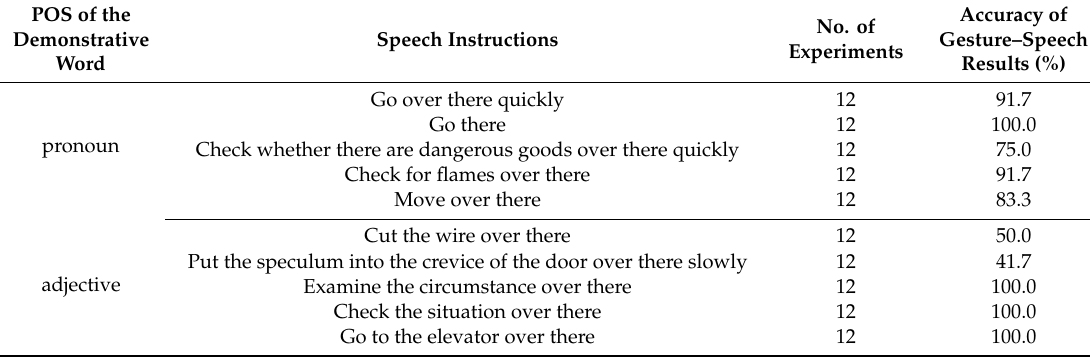
Figure 20. Sample images used in gesture–speech combination. Table 13. Experimental results using voice commands and hand postures.